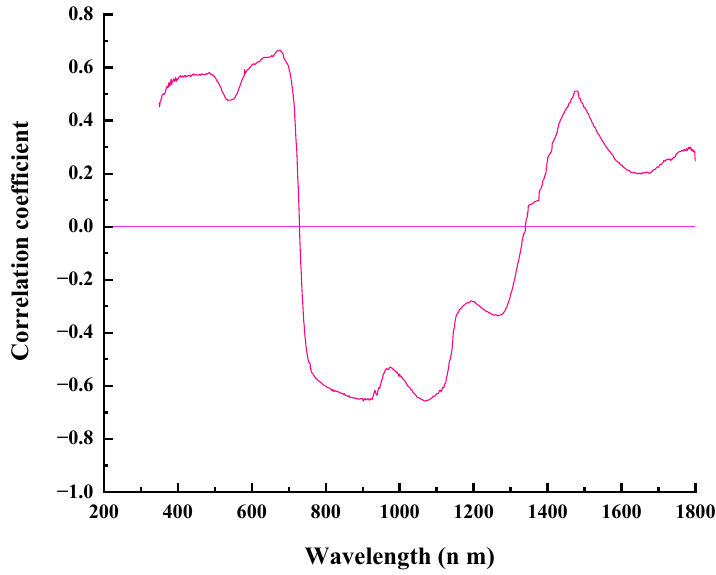
Figure 6. The correlation between the logarithm of the reciprocal of the canopy spectrum and the leaf area index.